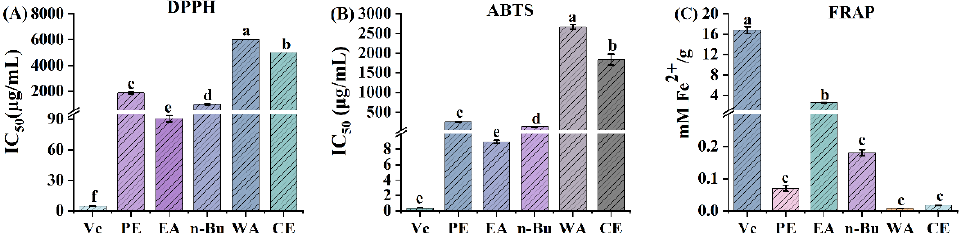
Figure 1. Antioxidant activity of petroleum ether (PE), ethyl acetate (EA), n-butanol (n-Bu), aqueous (WA) and crude extracts (CE) of P. sibiricum . ( A ) the IC 50 value of 2,2-diphenyl-1-picrylhydrazyl (DPPH) radical scavenging assay, ( B ) the IC 50 value of 2,2’-azinobis-(3ethylbenzthiazoline)-6-sulfonic acid (ABTS) radical scavenging assay, ( C ) ferric-ion-reducing antioxidant power (FRAP) assay. Mean values with different letters (a – f) were significantly different at a level of p < 0.05 ( n = 3) by DMRT (Duncan’s multiple range test).